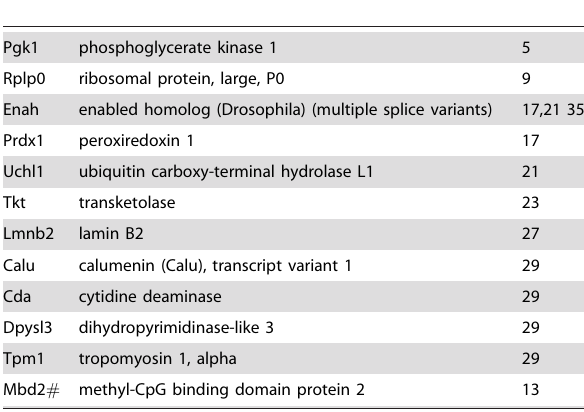
Table 5. Upregulated Genes in Fracture Healing Common to MSC and ESC